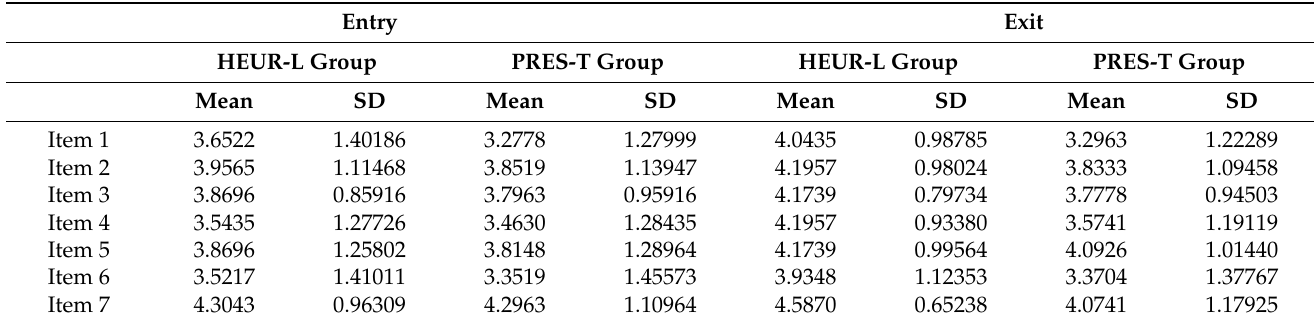
Table 3. Teamwork skills values, pre-test and post-test, after 3 months.